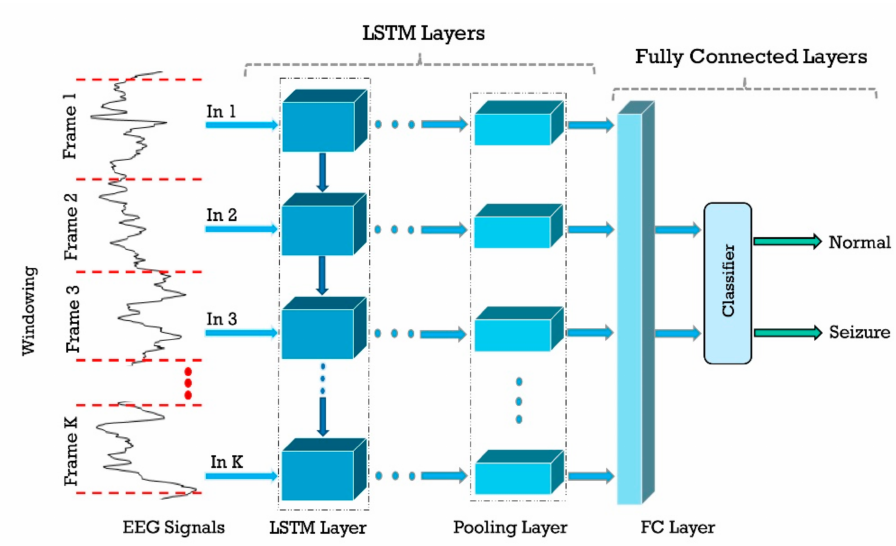
Figure 10. Sample RNN model that can be used for seizure